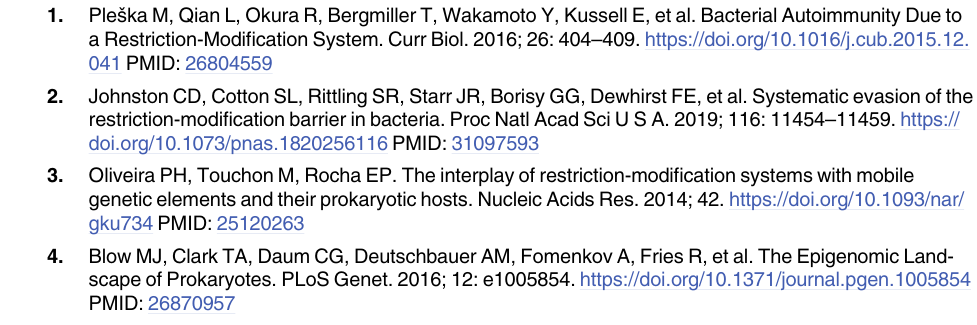
S3 Table. Complete list of C . acnes strains and GeneBank accession numbers used in this